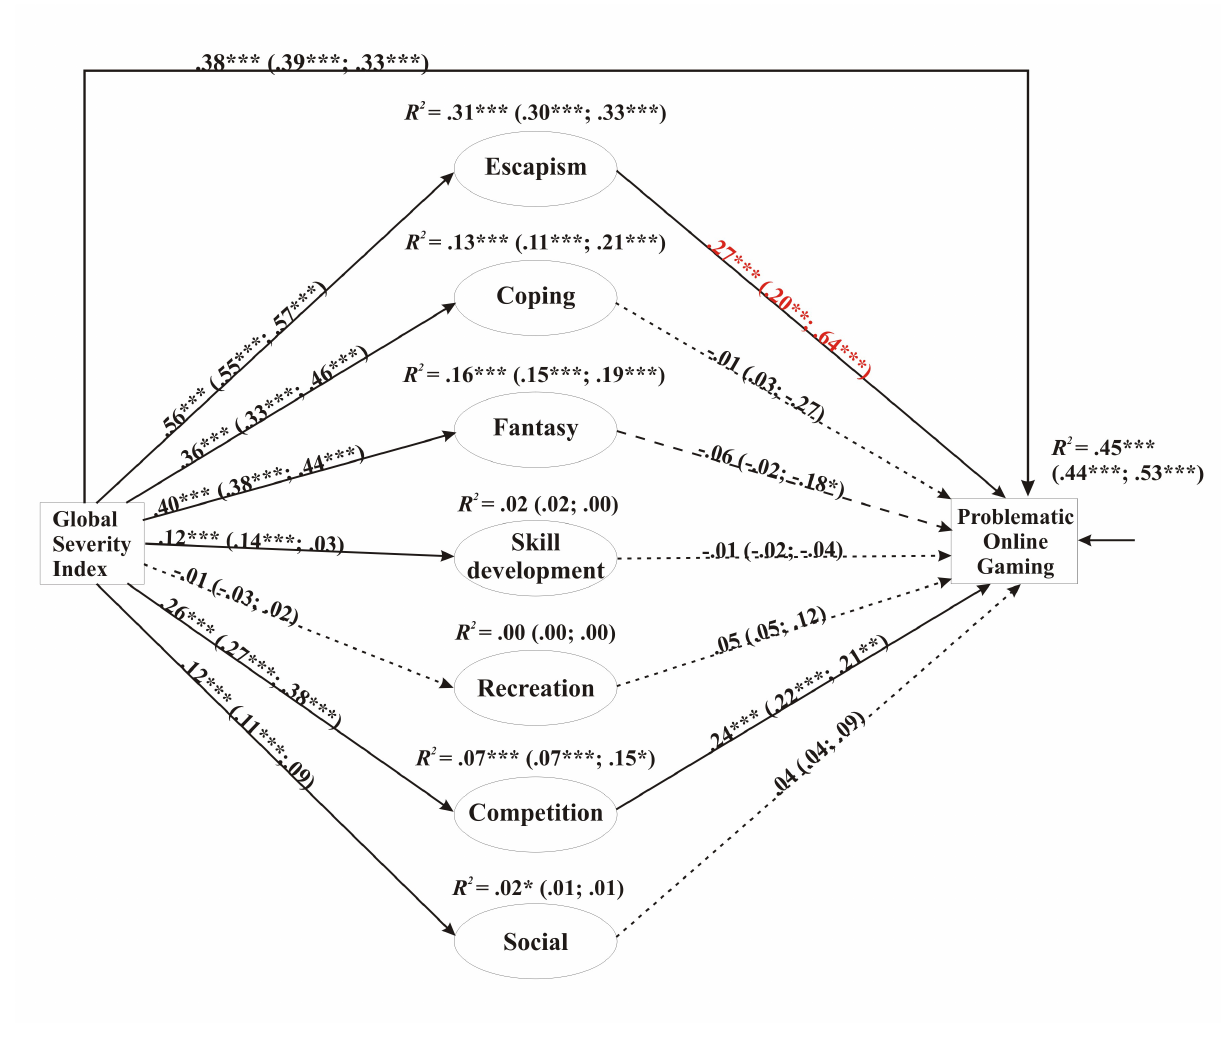
Figure 3. The mediation model and standardized path coefficients. Results of multigroup analysis and path coefficients across both genders (males/females) and the explained variance of the endogen variables ( R 2 ) (males: n=1226; females: n=240). The first values (left of the brackets) describe all MMORPG players. The first (left) values in the brackets describe male MMORPG players, whereas the second (right) values describe female MMORPG players. The color red indicates a significant difference between male and female players according to the Wald test. All 7 mediator variables are latent variables. For clarity, indicator variables associated with them have not been depicted in this figure but were published in an earlier paper [8]. Also for clarity, the covariances between the errors of all mediator variables have not been depicted in the figure. Simple arrows: significant path coefficients; dotted arrows: nonsignificant path coefficients; dashed arrow: nonsignificant path coefficients for males, significant path coefficients for females. * P <.05; ** P <.01; *** P